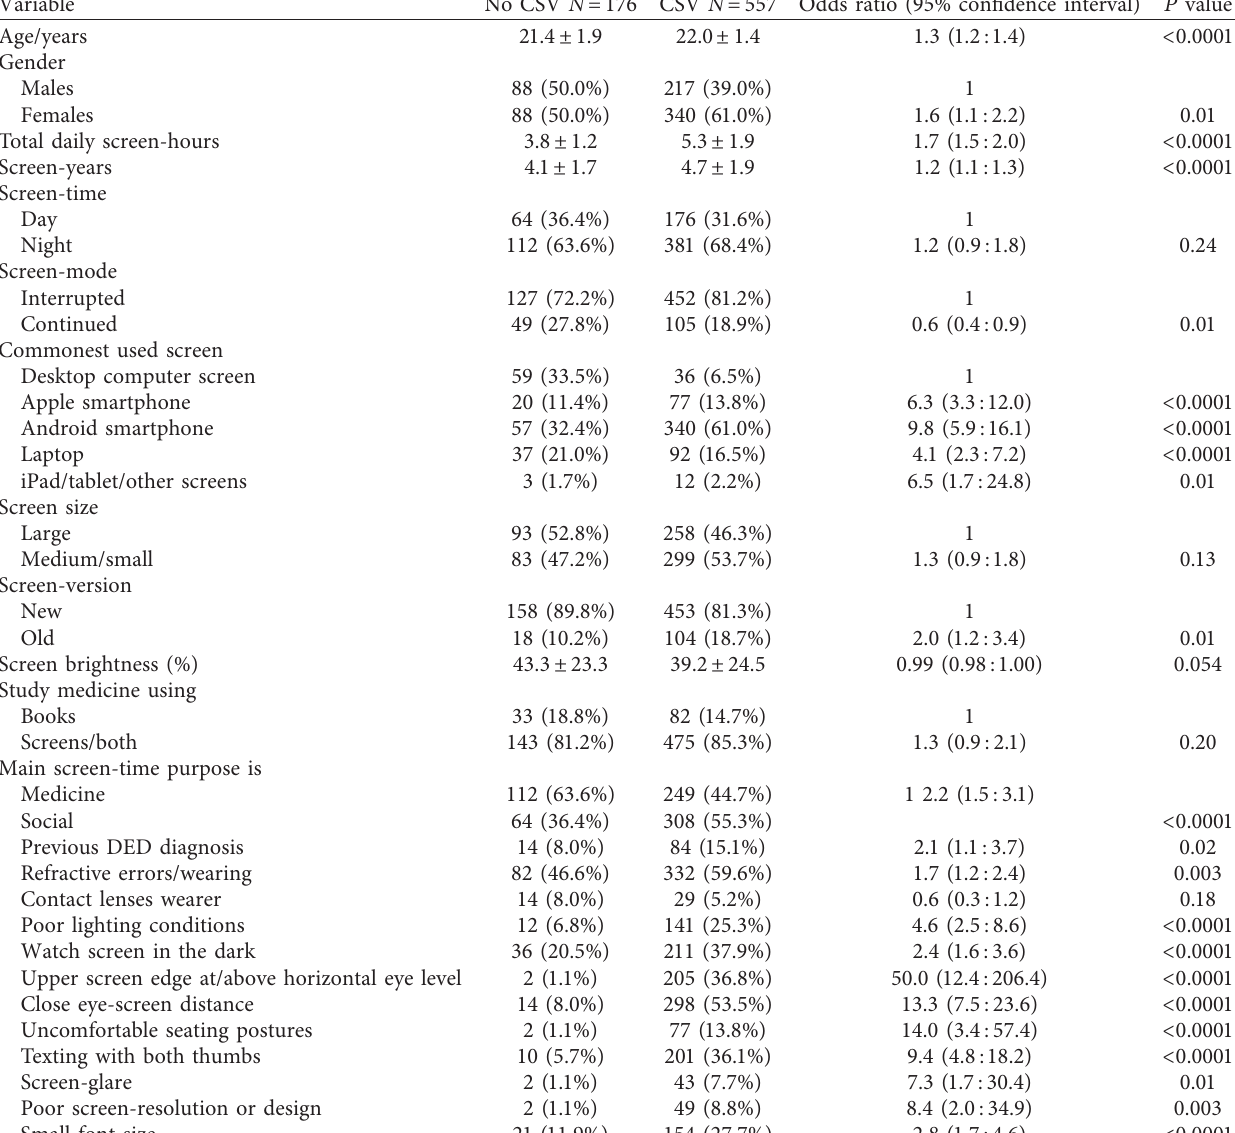
Table 2: Univariate logistic regression analysis model of factors affecting the occurrence of computer vision syndrome.